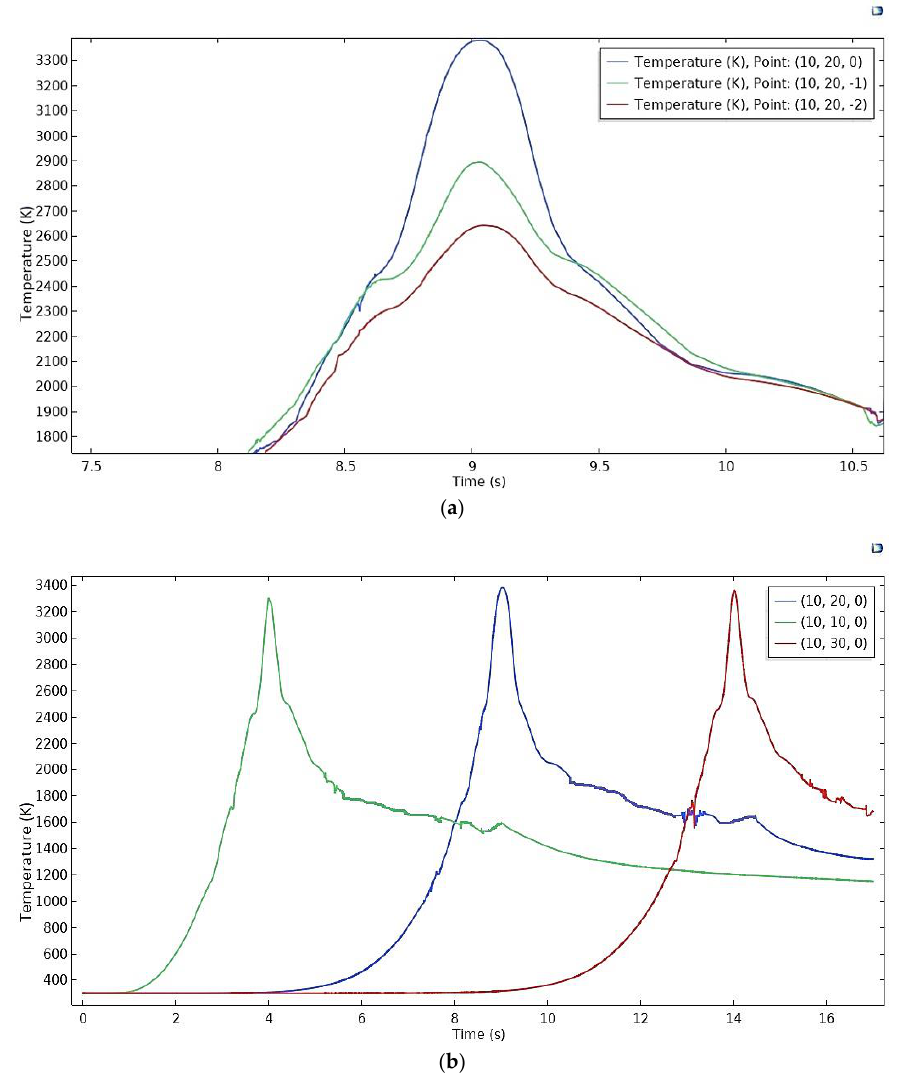
Figure 9. Temperature distribution of three different points ( a ) along the thickness perpendicular to the weld line and ( b ) along the weld line.